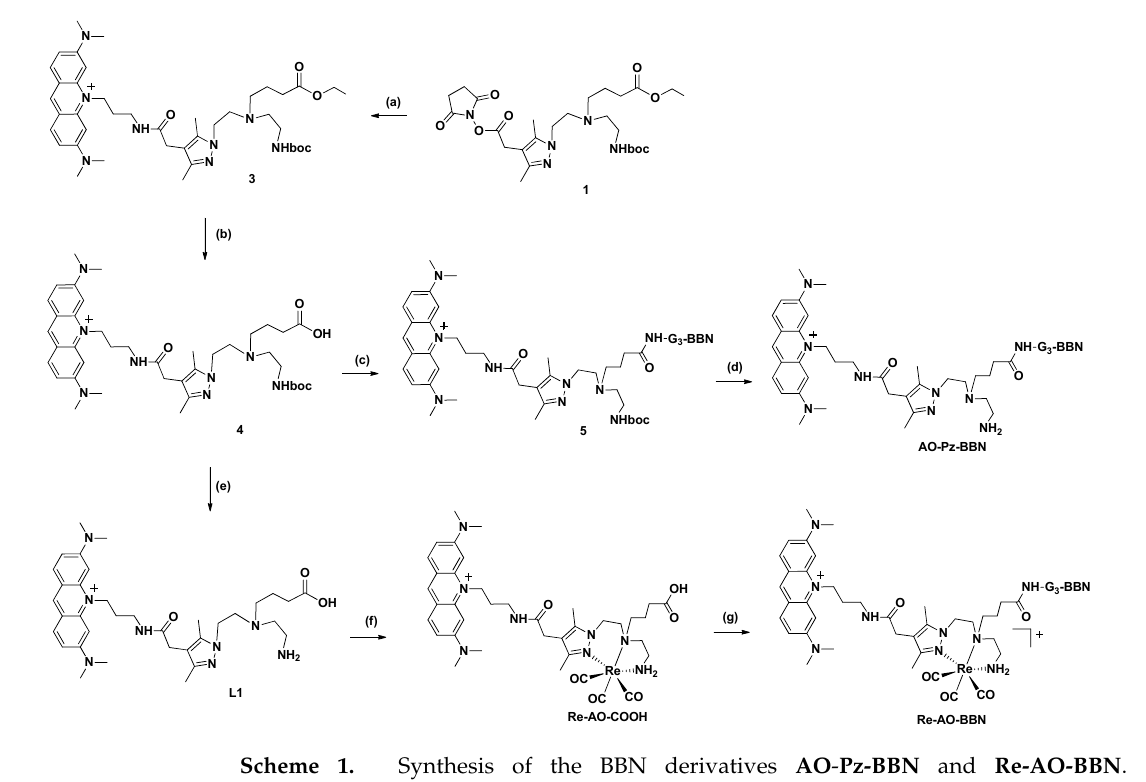
Scheme 1. Synthesis of the BBN derivatives AO - Pz-BBN and Re-AO-BBN . ( a ) 3,6-